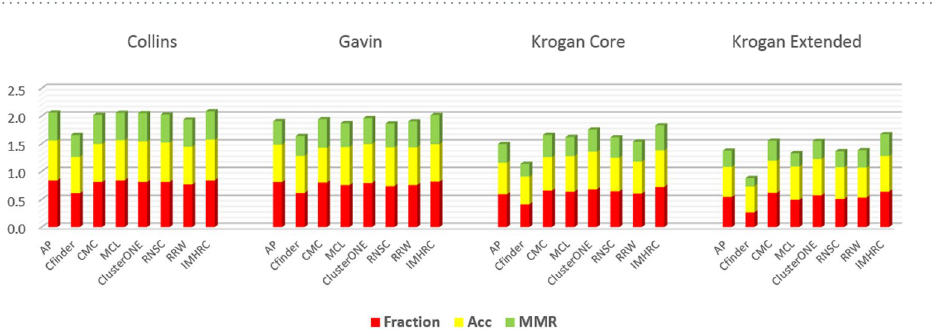
Figure 3. In this figure, we show results of all clustering methods on detection of a real complex based on the Krogan Extended dataset. The yellow nodes denote real complex and the blue nodes are others proteins. In addition, the halos represent results of algorithms. ( a ) The red halo shows the result of IMHRC. ( b ) The red and blue halos show the result of MCL and ClusterONE respectively. ( c ) The blue halo shows the results of RRW, RNSC and CMC. ( d ) The yellow and violet halos show the result of CFinder and AP respectively.